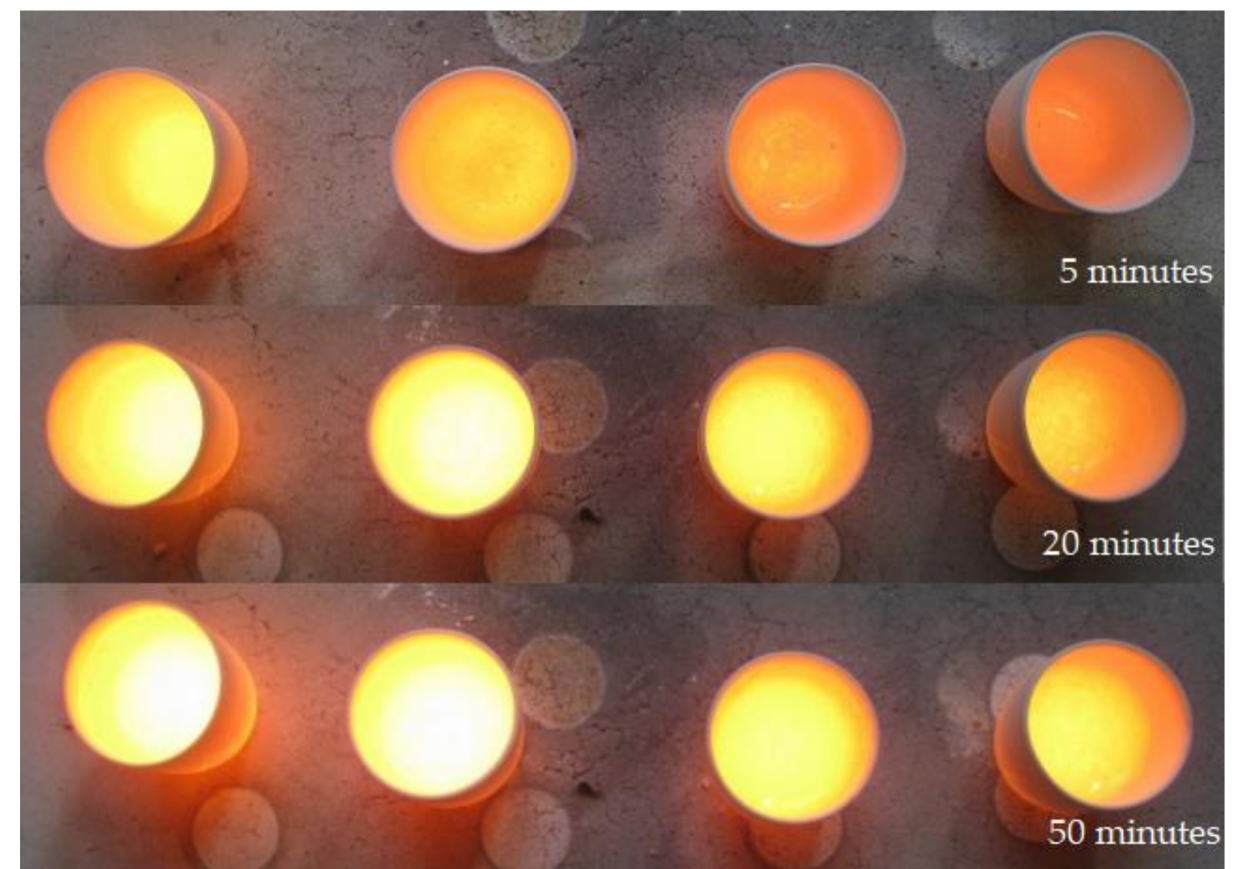
Figure 3. Glass melting after approx. 5, 20 and 50 min after the start of the melting process. From left to right A, B, C and D.